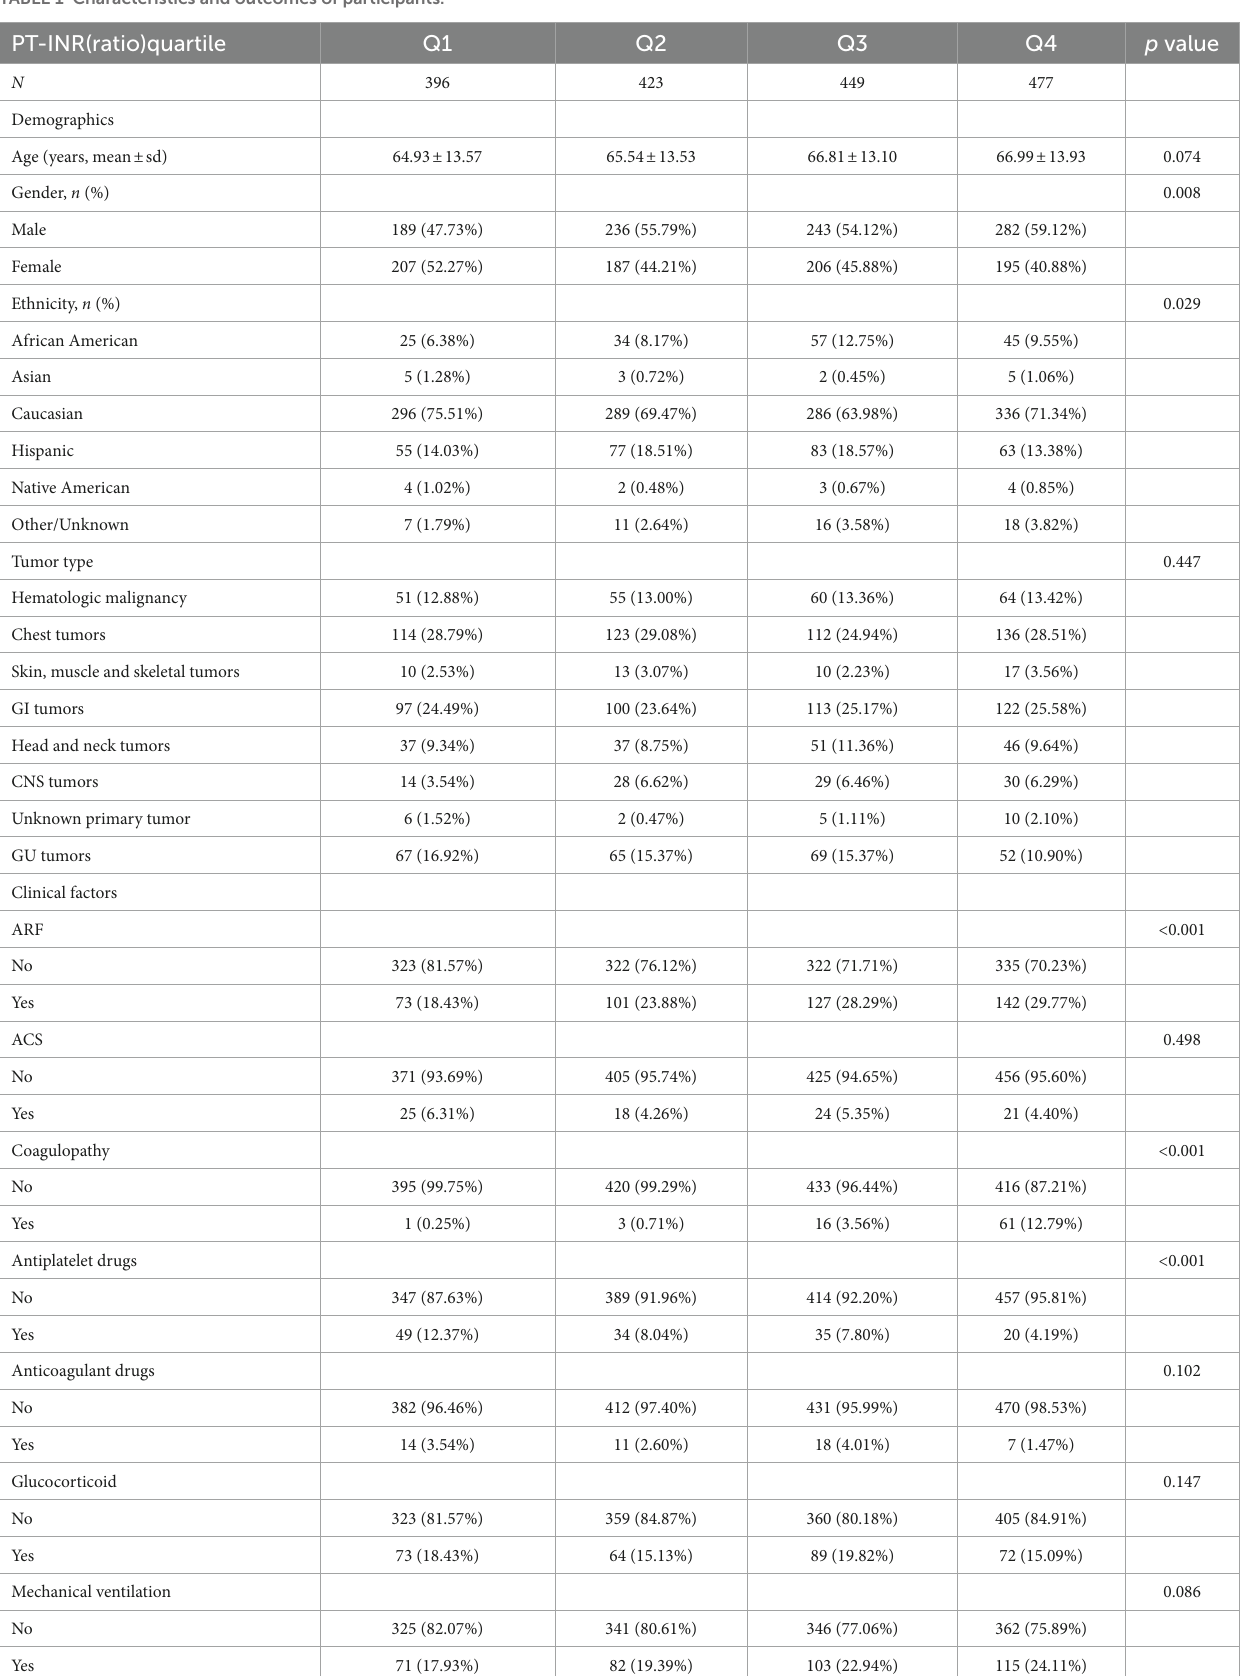
TABLE 1 Characteristics and outcomes of